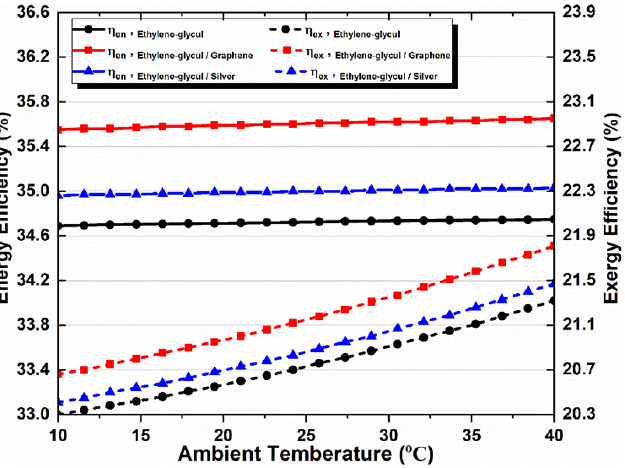
Figure 9. Effect of ambient temperature on exergy destruction rates of subsystems.